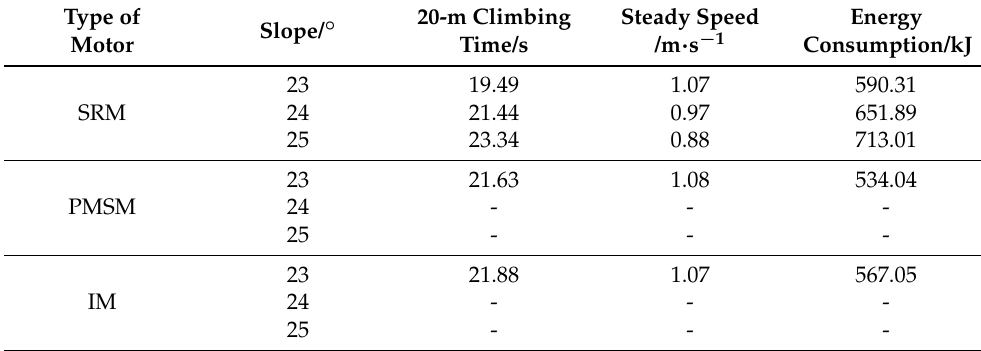
Table 9. Climbing performance of three